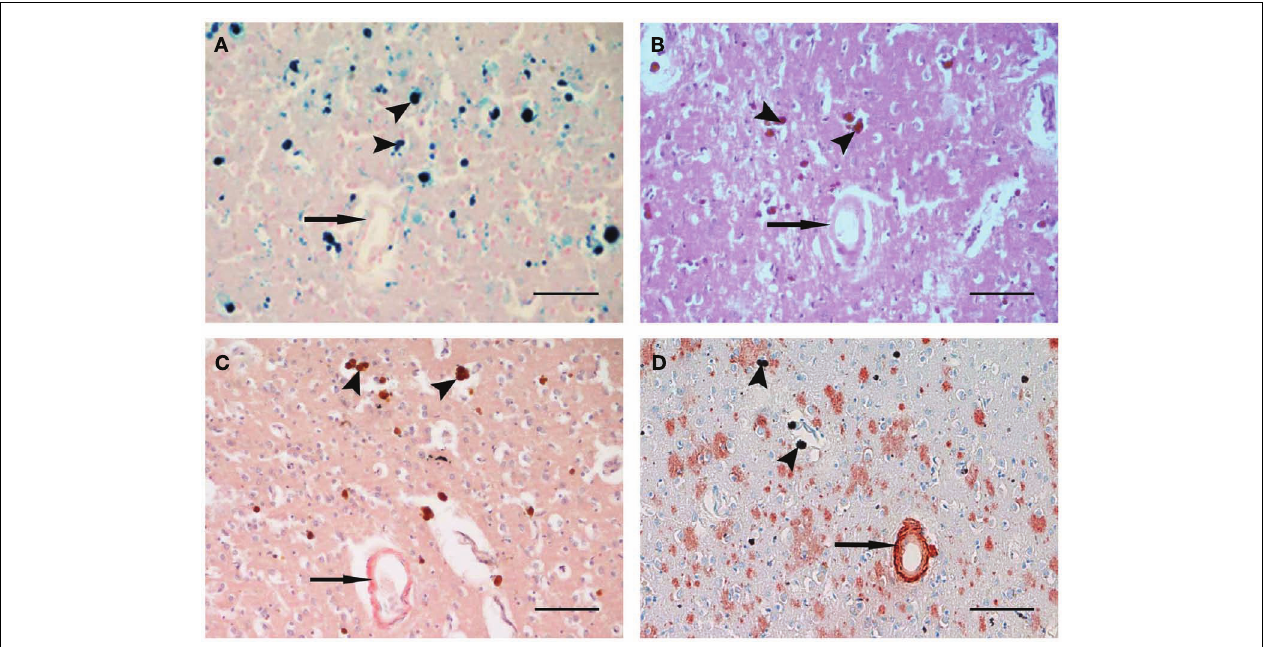
FIGURE 4 | Siderophages (arrow head) close to a small blood vessel with CAA (arrow) in the frontal cortex with subacute infarction. (A)